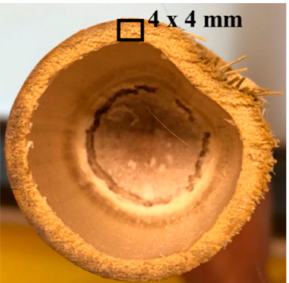
Figure 11. Square cross-section strips extracted from the bamboo